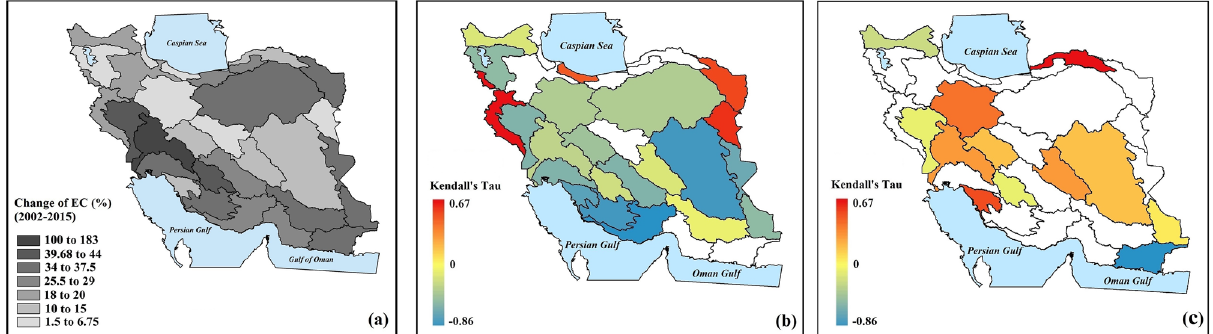
Figure 6. ( a ) Percent change in electrical conductivity (EC) during 2002–2015 across the 30 major basins in Iran and its significant dependence with basin-scale ( b ) changes in groundwater storage ( GWS ), and ( c ) human withdrawals ( H out ). Significant dependency is characterized by Kendall’s rank coefficients when p value ≤ 0.05 (This figure is created using ArcGIS